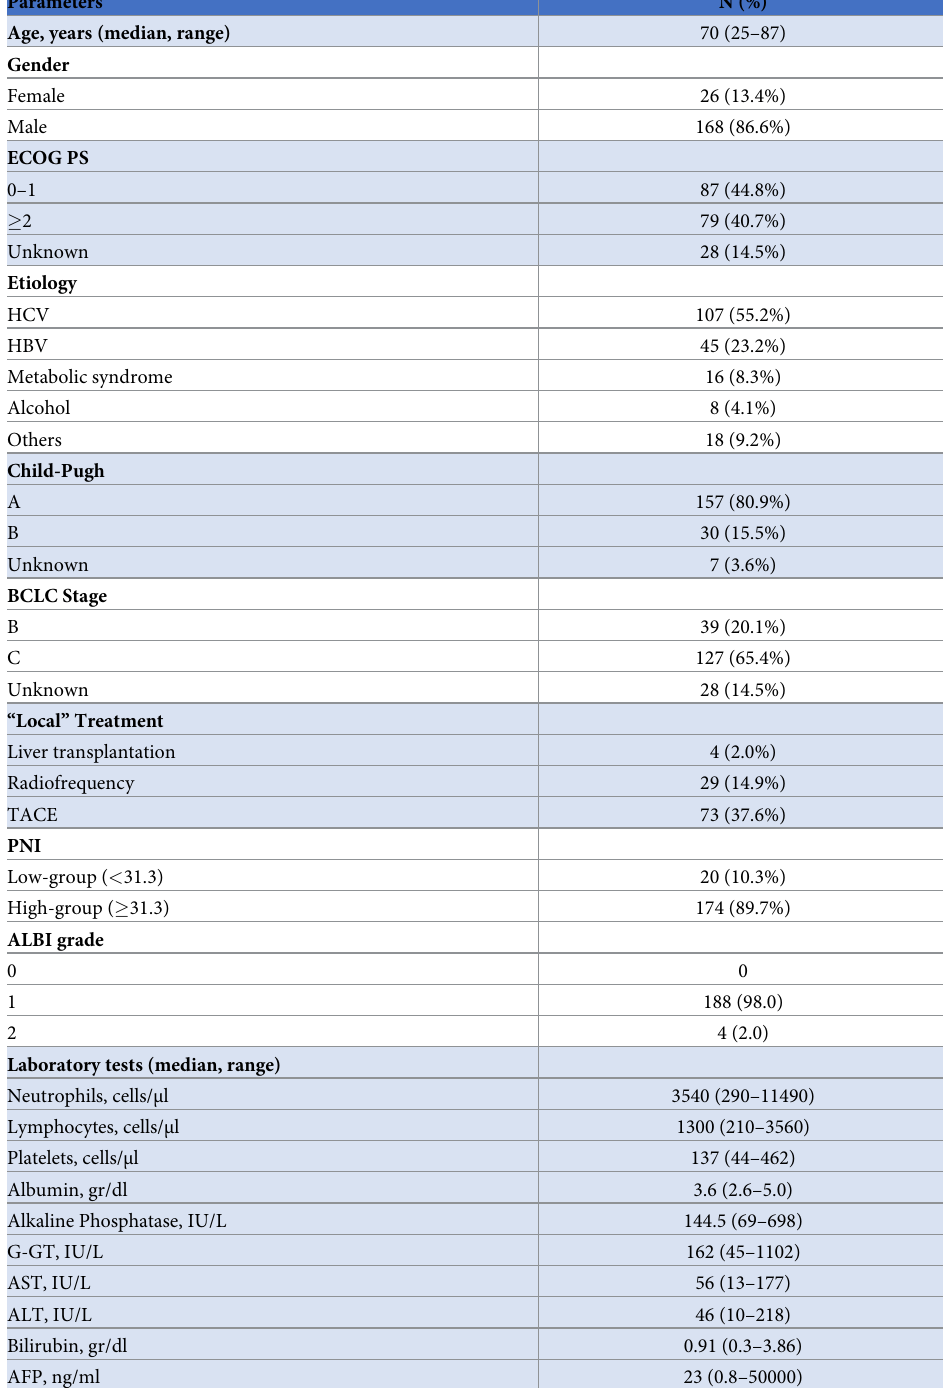
Table 1. Baseline characteristics of the training